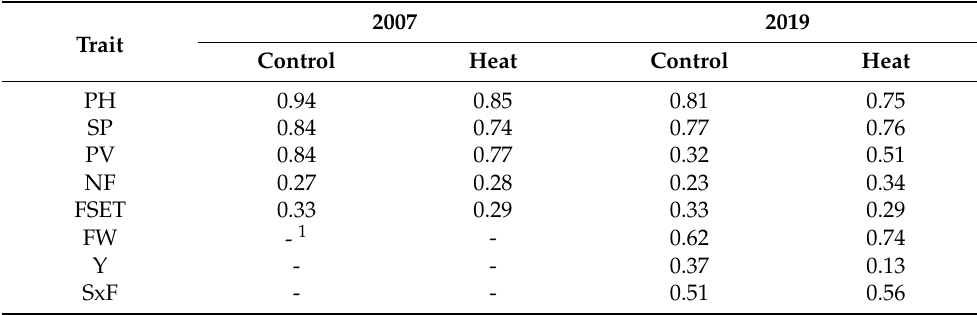
Table 4. Values of broad-sense heritability estimated in control and heat experimental fields for plant height (PH), stigma position (SP), pollen viability (PV), number of flowers per inflorescence (NF), fruit set (FSET) in 2007 and 2019 and, only in 2019, for fruit weight (FW), yield (Y), and number of seeds per fruit